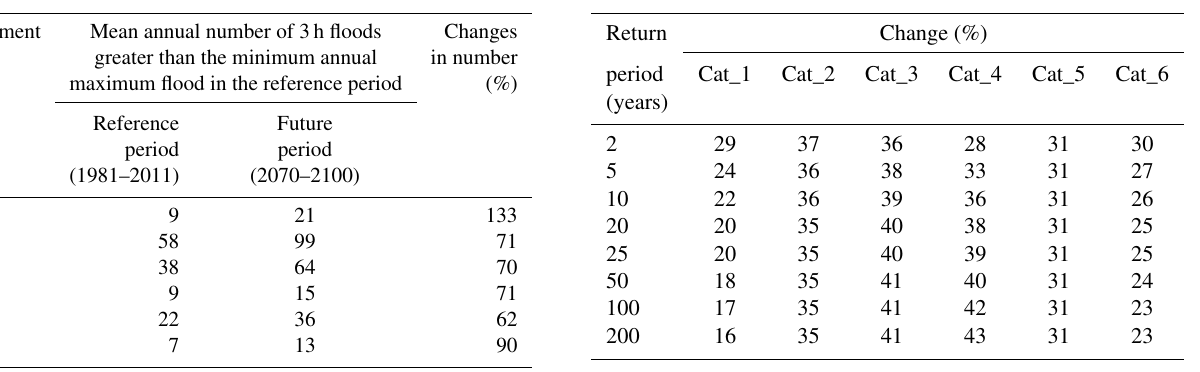
Table 9. Changes of floods with return periods of 2 to 200 years between the future and reference periods using Gumbel’s extreme value distribution for all study